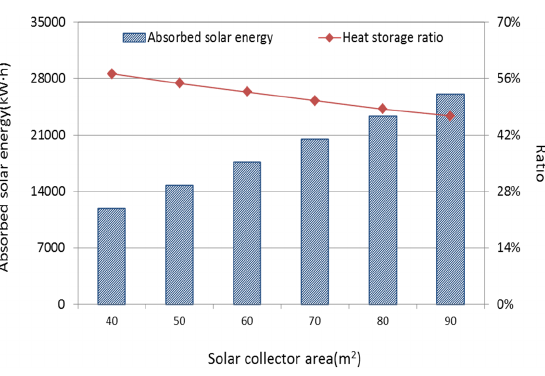
Figure 11. Simulation result of absorbed solar energy and storage ratio.